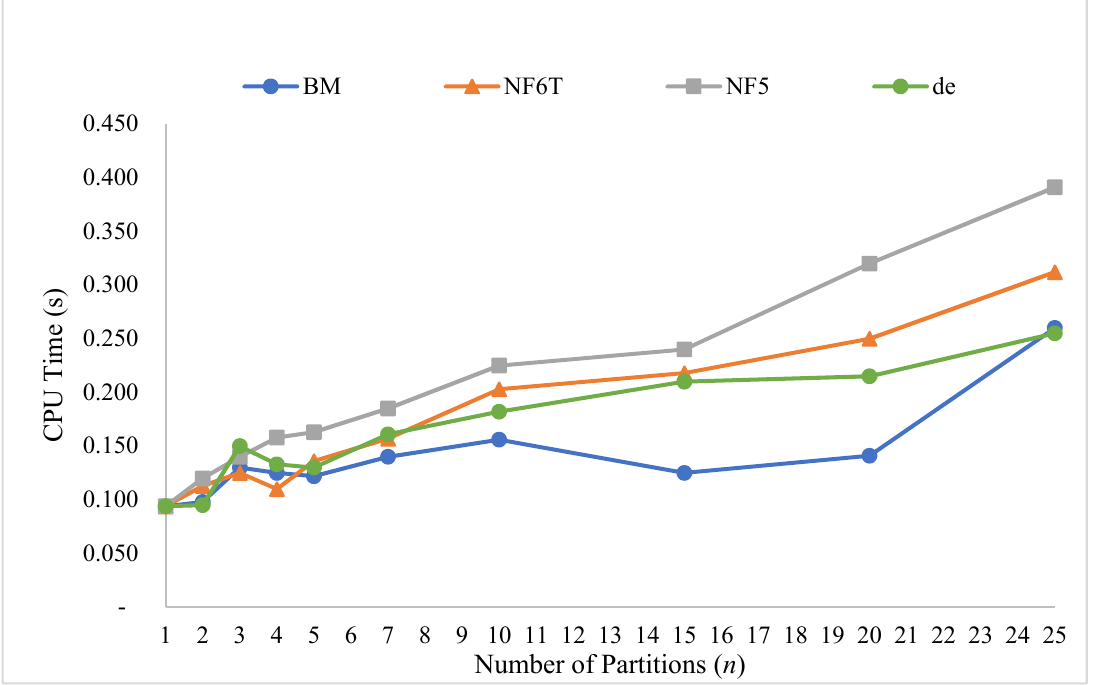
Figure 11. CPU times of the relaxation schemes.